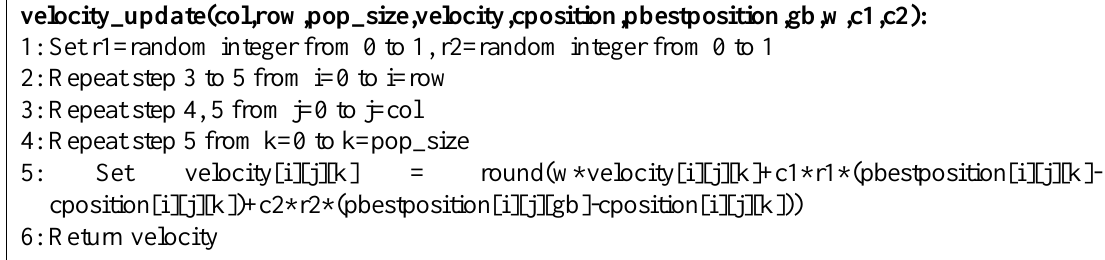
Algorithm 6. Function to update the velocity of